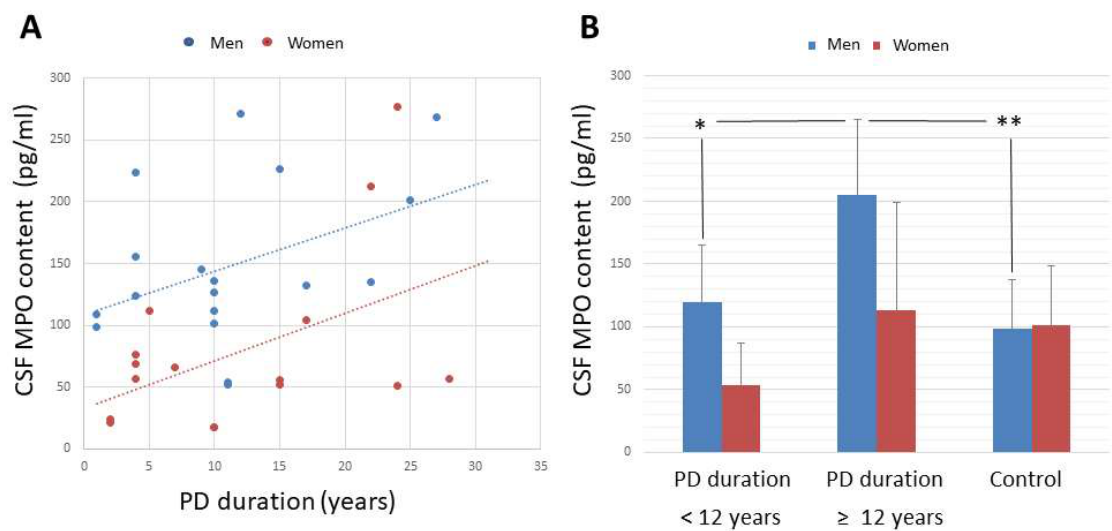
Figure 2. ( A ) Correlation between MPO level in the CSF and duration of Parkinson’s disease, and ( B ) CSF MPO concentration (pg/mL) in male and female patients with disease duration shorter than 12 years, and patients with PD duration ≥ 12 years. ( A ) CSF MPO concentration correlated with disease duration in both male and female patients (men, r = +0.469, p = 0.0496, n = 18; women, r = +0.565, p = 0.0226, n = 16). ( B ) CSF MPO concentration was observed to be significantly higher in male patients with disease duration ≥ 12 years (206 ± 61 pg/mL, n = 11) than in the remainder male patients (119 ± 45 pg/mL, n = 7), and control men (98 ± 39 pg/mL, n = 13). Mean ± standard deviation, * p < 0.01, ** p < 0.001. Abbrev.: CSF, cerebrospinal fluid; MPO, myeloperoxidase; PD, Parkinson’s